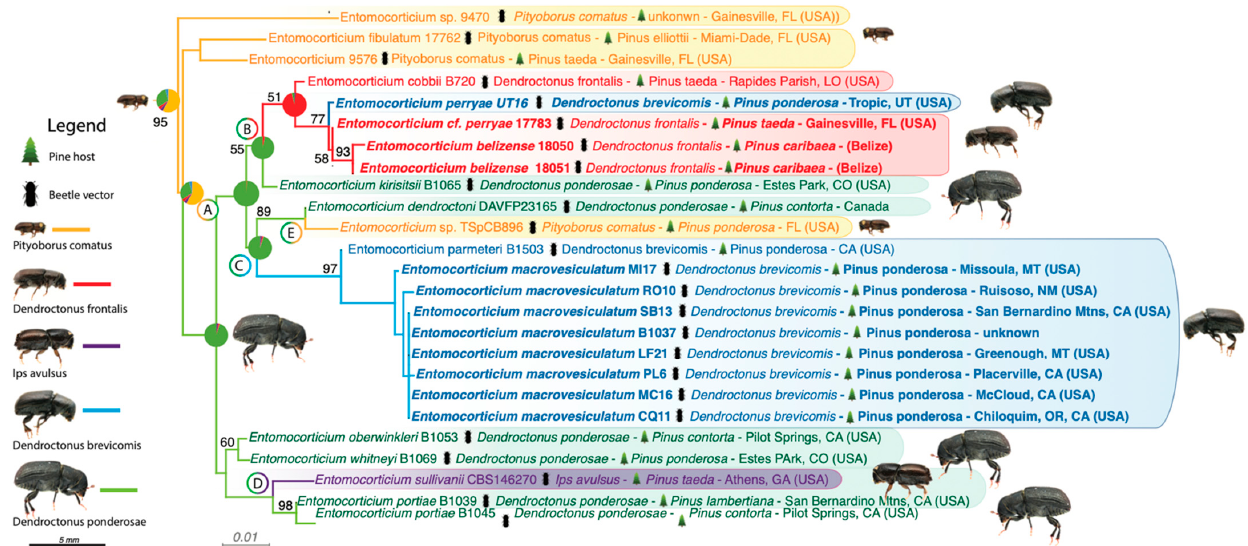
Figure 2. Close-up of the Entomocorticium clade showed in Figure 1. Character-state reconstruction of the association of Entomocorticium spp. with beetle vectors. Branch and boxes color mean: Yellow = Pityoborus comatus ; Red = Dendroctonus frontalis ; Blue = D. brevicomis ; Green = D. ponderosae ; Purple = Ips avulsus . Node A indicates transition from Pityoborus comatus to Dendroctonus ponderosae , node B from D. ponderosa to D. frontalis , node C from D. ponderosae to D. brevicomis , node D from D. ponderosae to Ips avulsus and node E from D. ponderosae back to P. comatus . Scale bar is in relation to the beetle sizes = 5 mm. Beetle photos by Andrew Johnson.